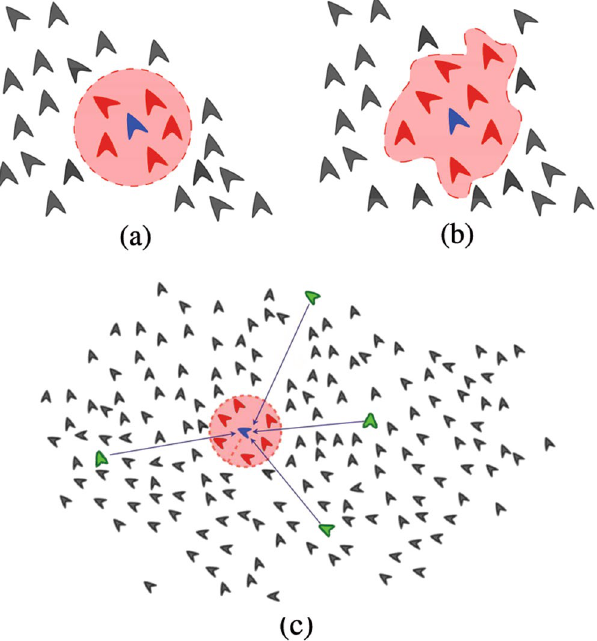
Figure 1. Schematic representation of different interactions for an arbitrary particle p i (represented in blue). Short-range interactions can be defined either ( a ) metrically, where each particle interacts with the ones falling within a circular neighborhood of fixed radius r 0 , or ( b ) topologically where each particle interacts with its first = 7). In each case, the red particles α α l neighbors regardless of their relative distance. (In this example l constitute the local neighborhood U i ( t ) of p i , whereas the gray particles outside the shaded area constitute the complementary set ⁎ U t ( ) . ( c ) In addition to short-range interactions within the local neighborhood U i ( t ), each i particle p i also has a certain number κ i of long-range interactions with distant neighbors, indicated here by the green particles which constitute the distant neighborhood L i ( t ) of p i . (In this example κ i =